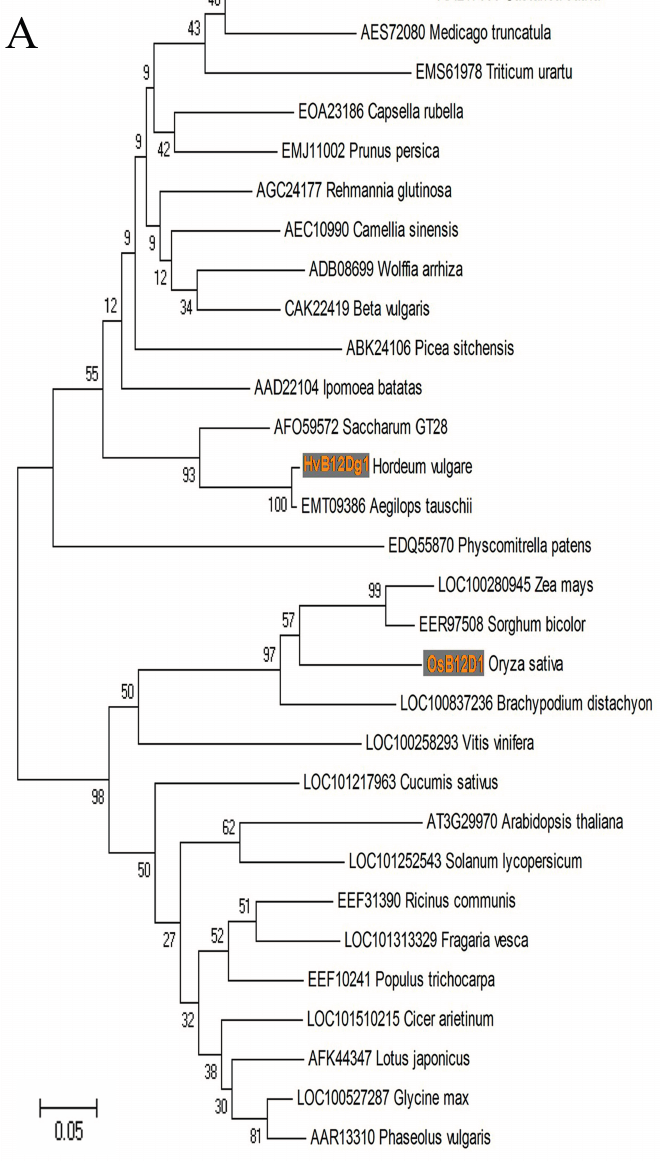
Figure 1. Sequence analyses of OsB12Ds ( A ) Phylogenetic analysis of OsB12D1 protein using neighbor-joining method with MEGA 4; bootstrap values from 1000 replicates are indicated at each node; the scale bar represents 5% sequence divergence. Those proteins were divided into two distinct clades, OsB12D1 and HvB12Dg1 belonged to different clades, respectively; ( B ) Gene structures of six OsB12Ds . green line, exons; gray line, introns; blue line, 3' or 5' un-translated region; ( C ) Multiple sequence alignment and transmembrane region of OsB12Ds proteins. Identical, conservative (5/6–1) and block (3/6–4/6) of similar amino acid residues are shaded in deep blue, cherry red and blue, respectively. The transmembrane regions and conserved motifs were marked by red rectangle and blue lines, respectively.